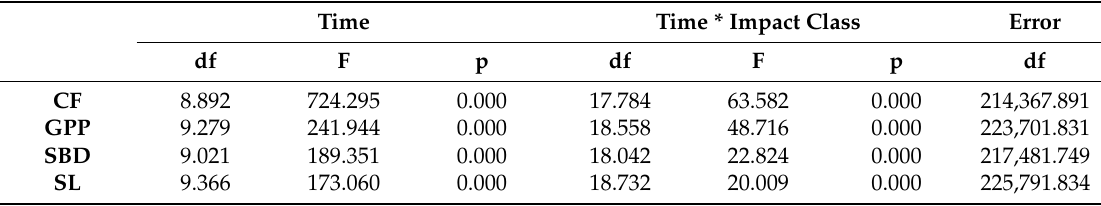
Table B1. Overall significance of differences in 2002–2012 phenology and green biomass production observed within the spatial representation of the 3nNDVI PC, considered without and with stratification into drought impact classes (3 levels). Abbreviations correspond with Table A1.